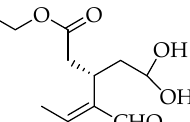
Figure 6. 1 HNMR spectra of fraction 3, oleocanthal (3 S ,4 E )- 9 .